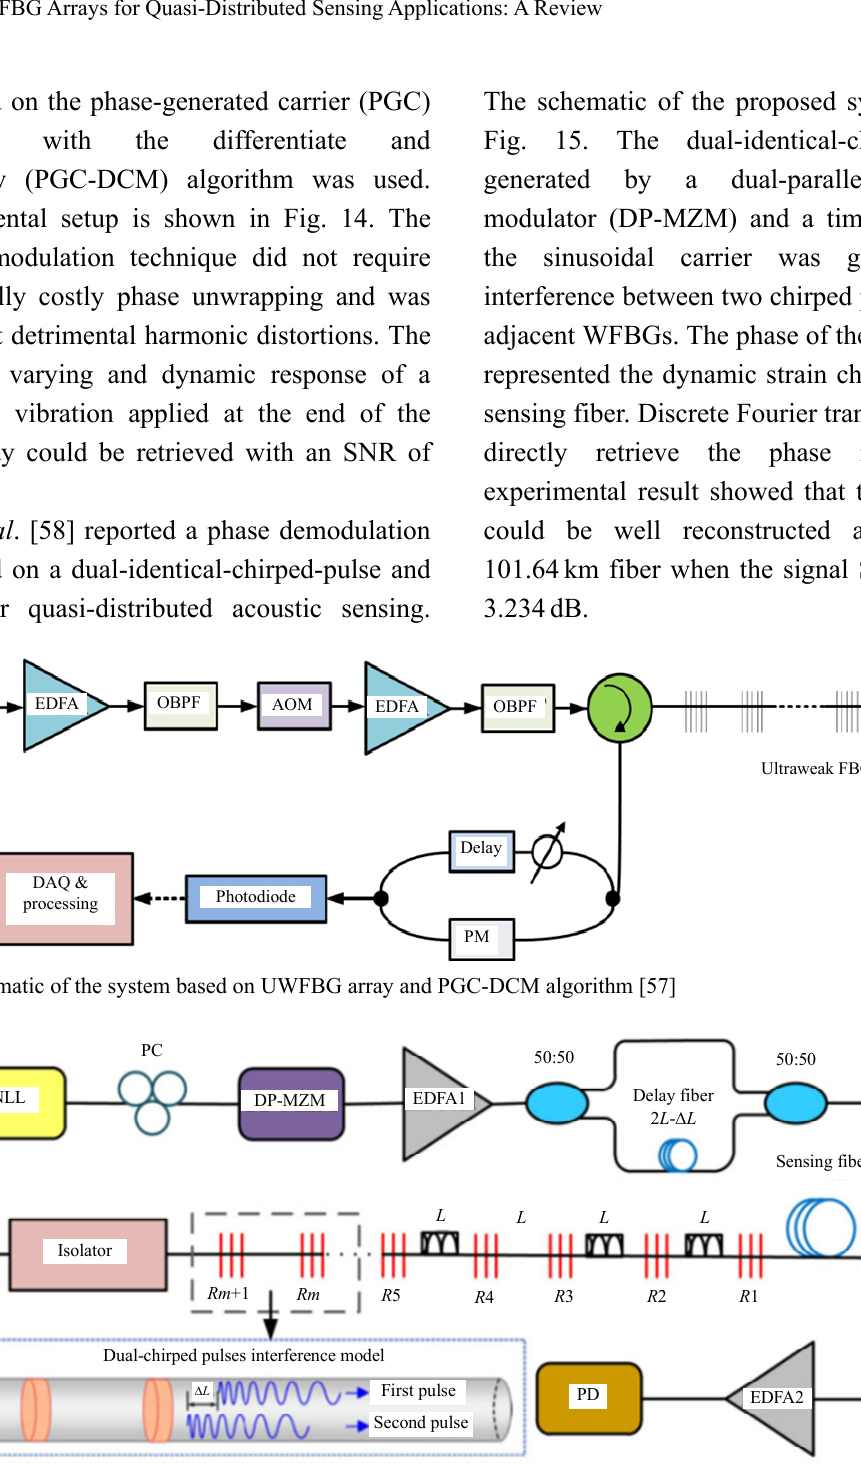
Fig. 15 Phase demodulation method based on a dual-identical-chirped-pulse and UWFBG array